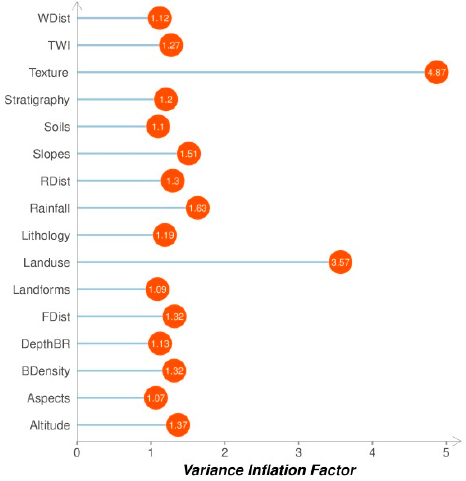
Figure 8 . Variance inflation factors analysis results on landslide conditioning factors.